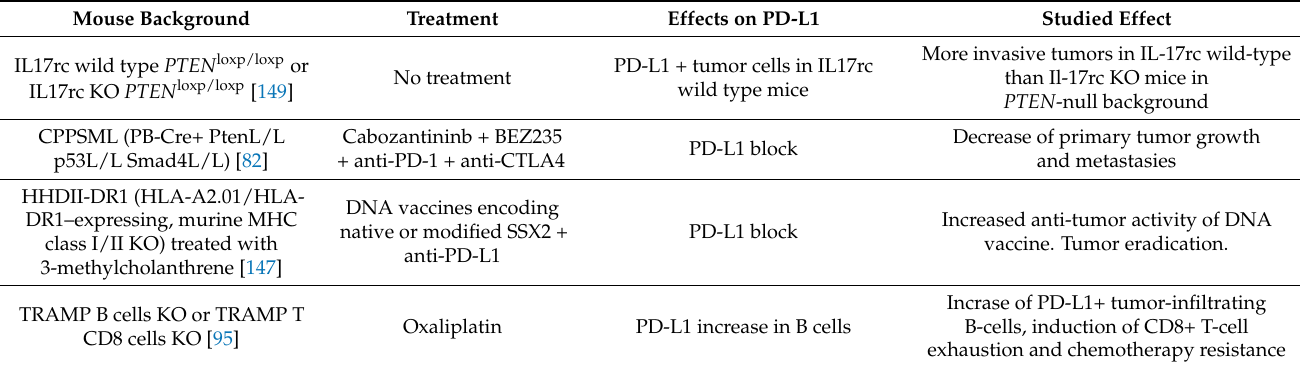
Table 3. Spontaneous mouse models of prostate